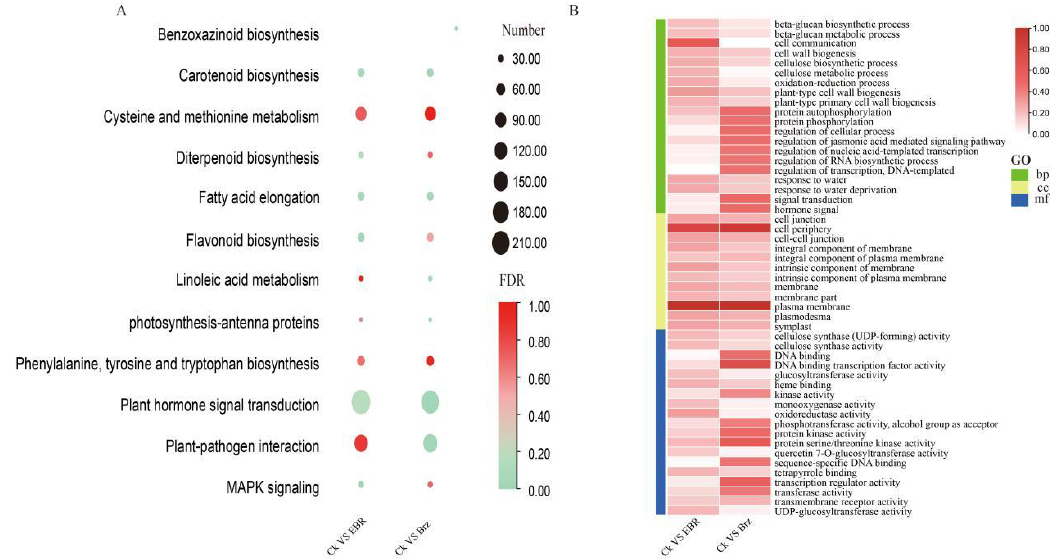
Figure 2. Enrichment analysis of BR-responsive transcriptome changes in maize leaves. ( A ) KEGG enrichment analysis of DEGs shown in a bubble chart. ( B ) GO enrichment analysis of DEGs shown in a heat map.